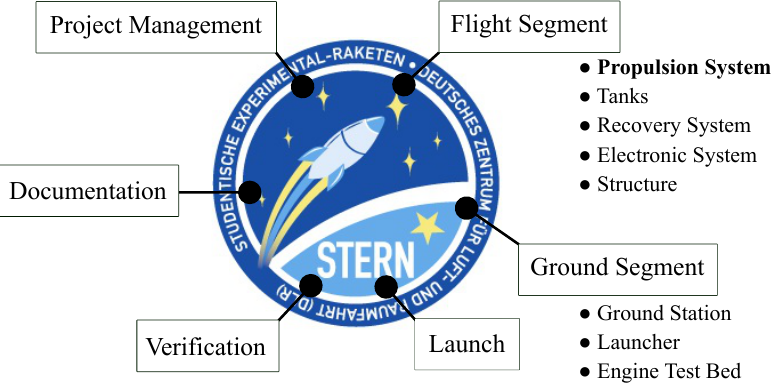
Figure 1. Overview of the STERN II project contents (STERN program logo [22]).